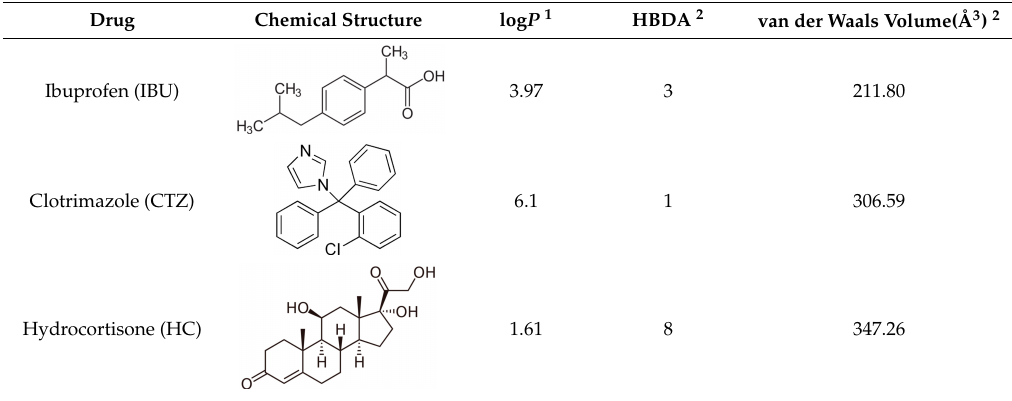
Table 1. Chemical structure, n -octanol water partition coe ffi cient (log P ), number of hydrogen bond donors and acceptors (HBDA), and van der Waals volume.